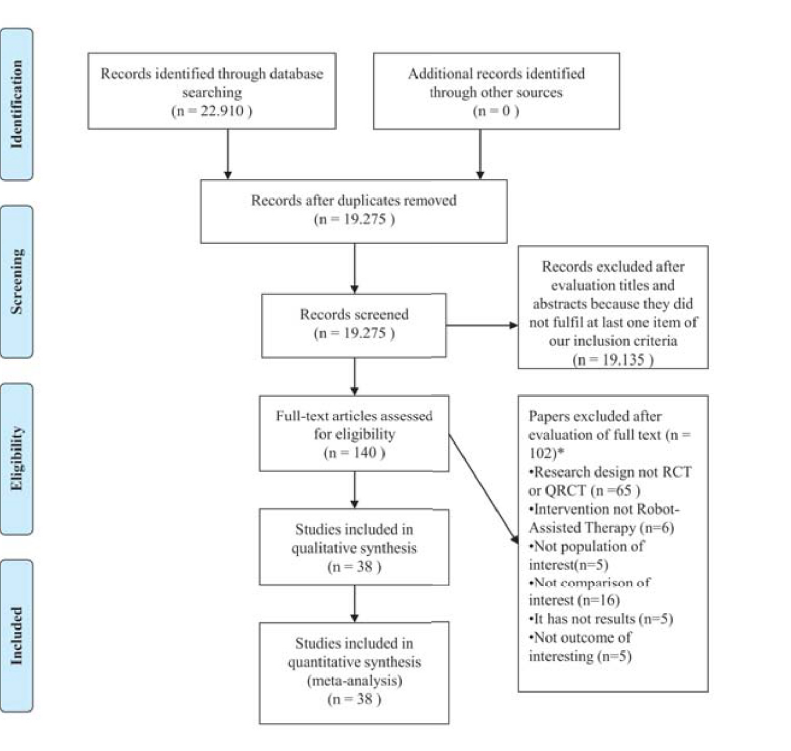
Fig 1. Flow chart of studies through the review. (cid:3) Papers may have been excluded for failing to meet more than one inclusion criteria. Abbreviations: RCT = randomized controlled trials; QRCT = quasi-randomized controlled trials.